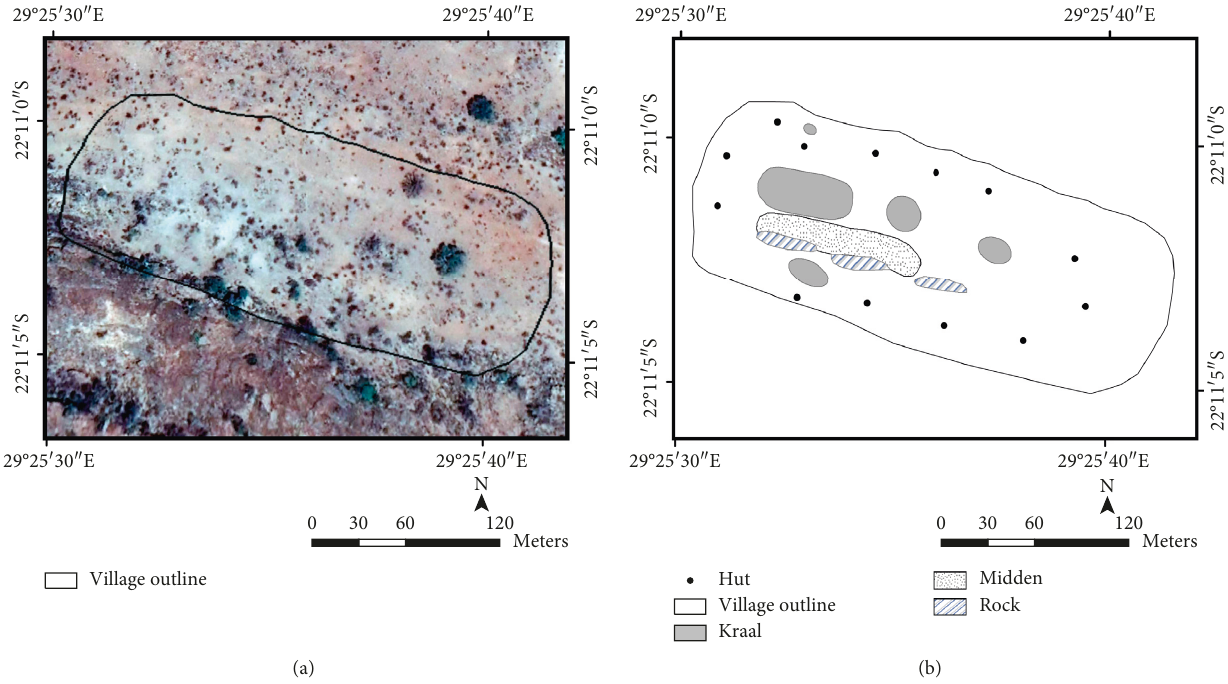
Figure 2: Schroda site as visible from (a) RGB Google Earth imagery; (b) a sketch detailing the outline of the early farming community village as interpreted by Hanisch from excavation and survey (adapted from